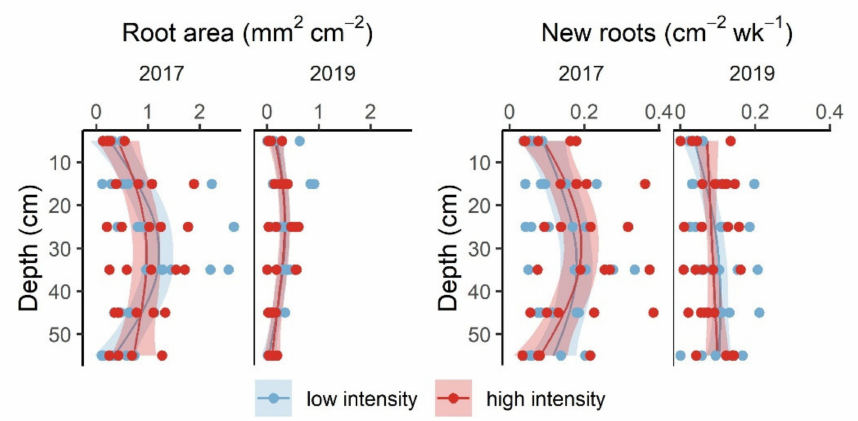
Figure 6. Root area (left panels) and new root growth rate (right panels) in low- versus high- precipitation-intensity treatment plots. Values are means of twice-monthly measurements during the growing seasons of 2017 and 2019. Lines show the predicted values from the GAMMs, and the shaded regions are 95% confidence intervals. Treatments were grouped into two precipitation intensity categories: low intensity (1 mm, control, 2 mm, and 3 mm treatments) and high intensity (4 mm, 8 mm, and 18 mm treatments). While the null models outperformed the models presented here (indicating no significant treatment responses; Table S5), they are shown to illustrate our